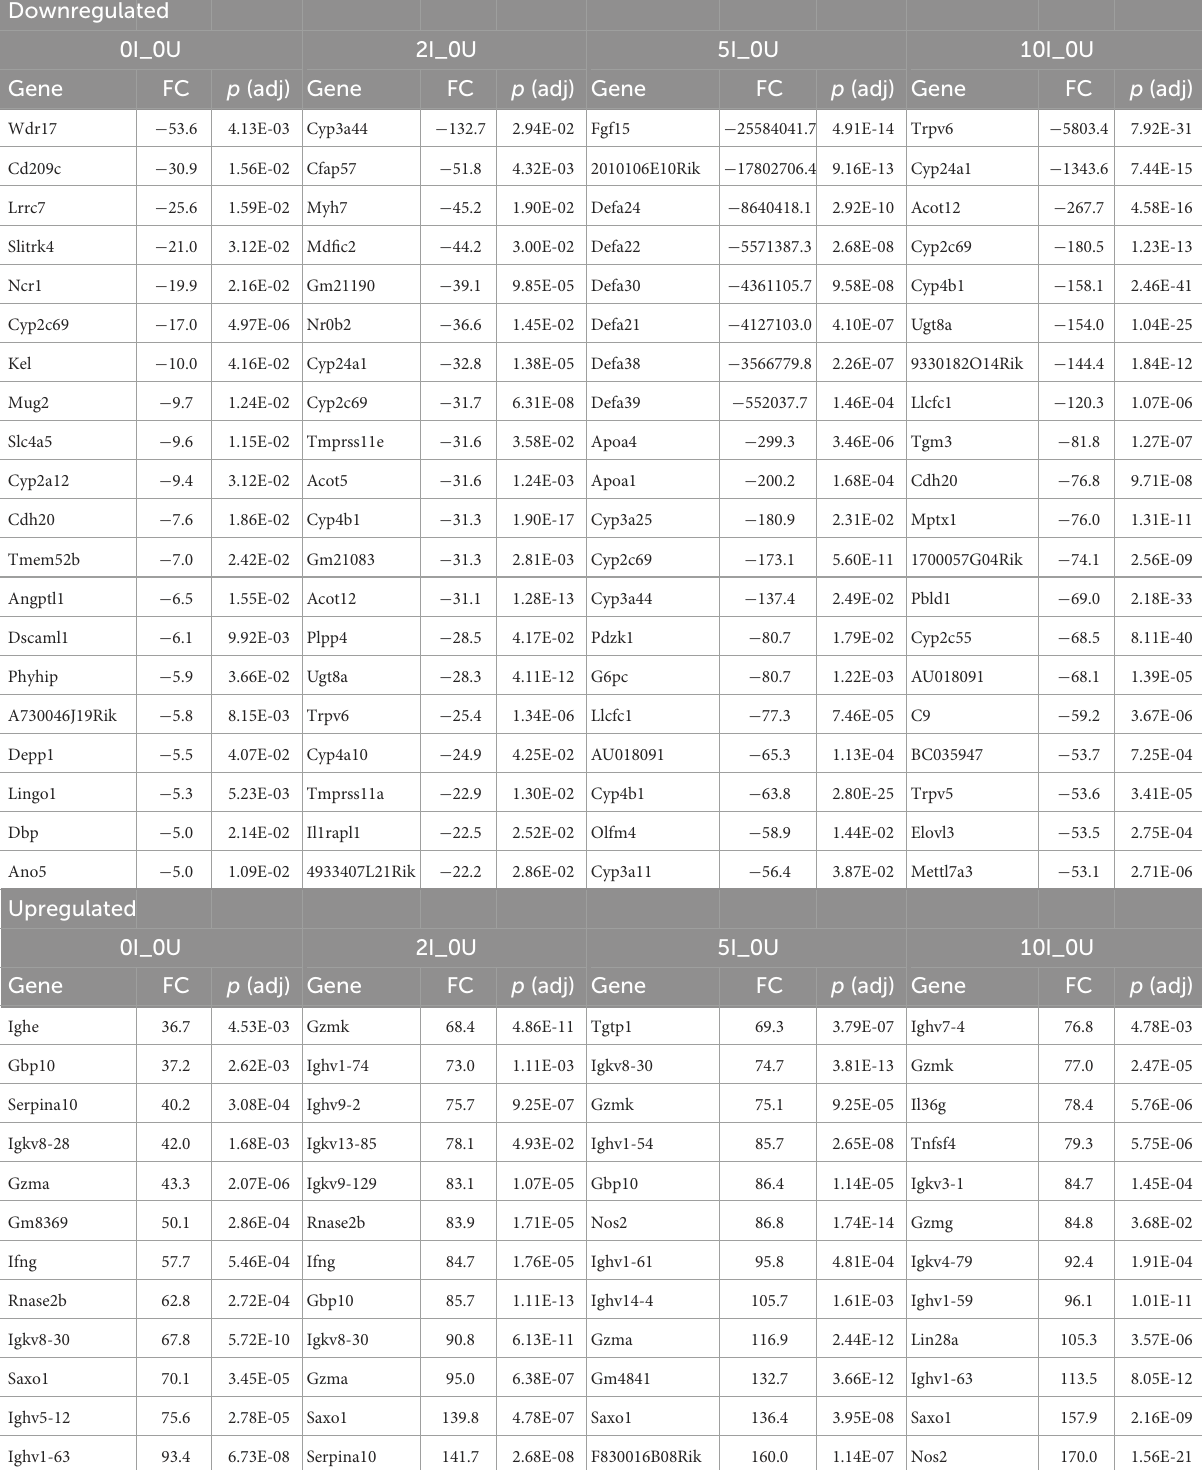
TABLE 3 Top 20 differentially expressed genes in the infected